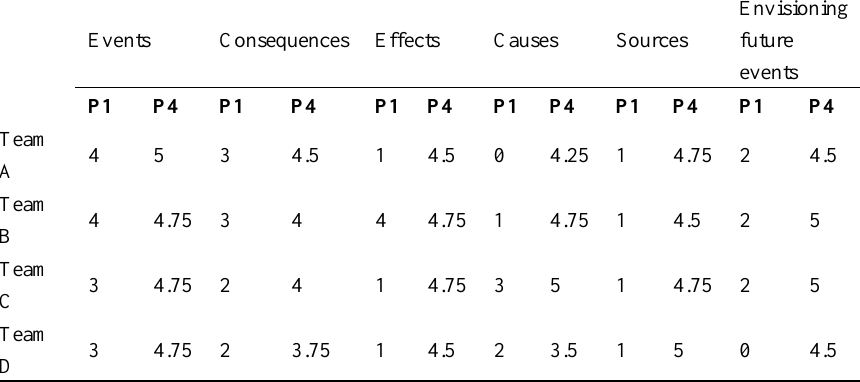
Table 3: Scores for the four